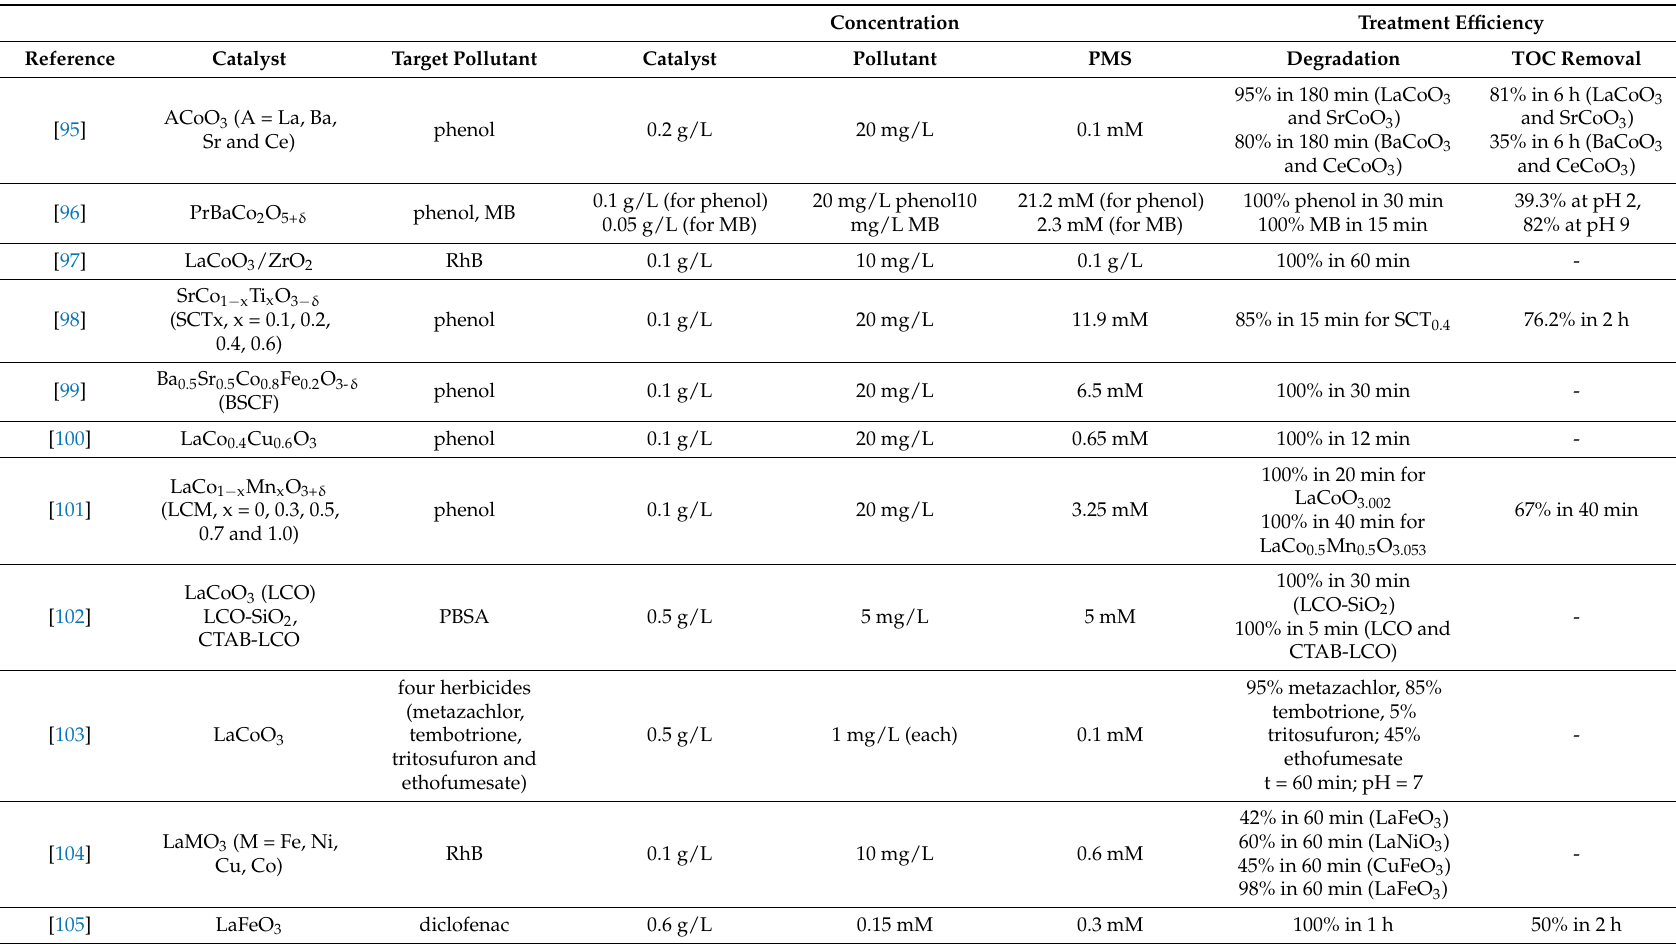
Table 2. Degradation of pollutants by the combination of peroxymonosulfate (PMS) and oxides type